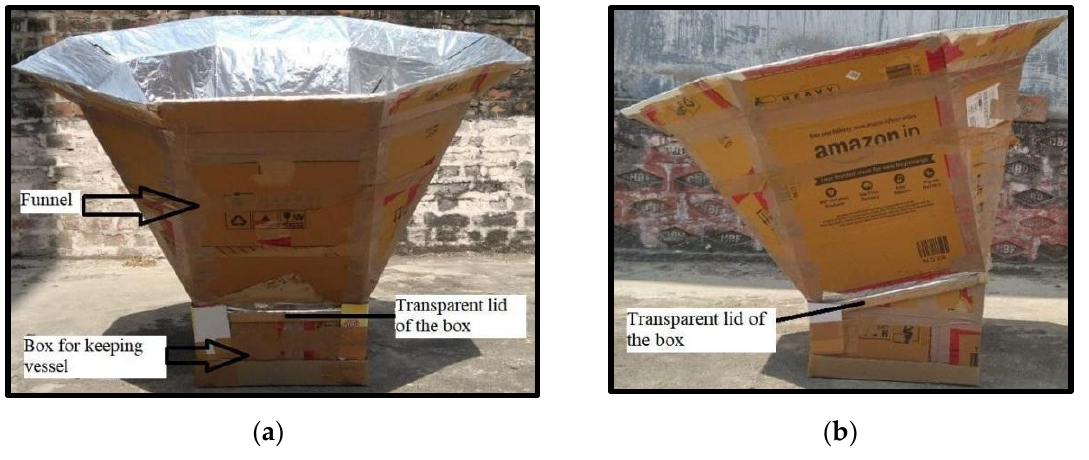
Figure 3. ( a ) Front view of the funnel-type solar cooker when put together. ( b ) Side view of the funnel-type solar cooker.